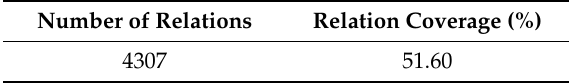
Table 10. Overall relation statistics for the initial annotated corpus.